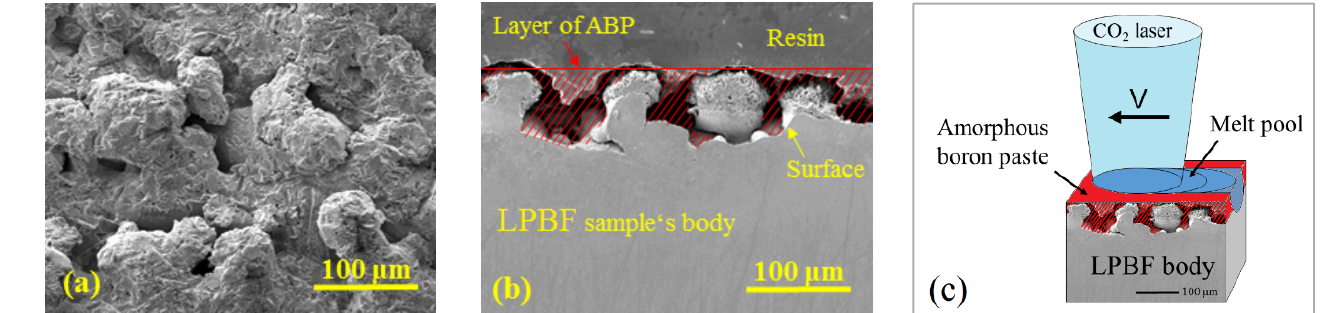
Figure 2. Morphology of side-on surface of as-manufactured LPBF sample ( a ) and a cross-sectional micrograph of LPBF sample with the schema of pre-placing amorphous boron paste (ABP) ( b ); ( c )–schematic diagram of laser boronizing process. Table 2. Applied laser radiance exposure (in J ∙ mm − 2 ) at 0.5–4.0 mm laser spot diameter and 250–1500 mm/min laser operating speed.